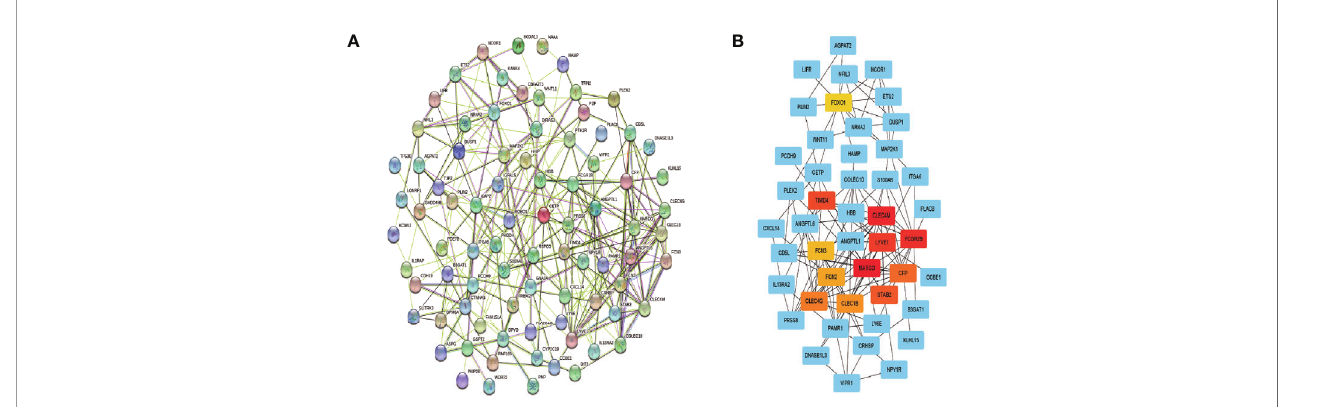
FIGURE 8 | PPI network construction and hub genes screening. (A) PPI network of the overlapping genes was constructed using Cytoscape software based on STRING database. (B) The top 12 genes with the highest mcc score were selected as hub genes from the PP.